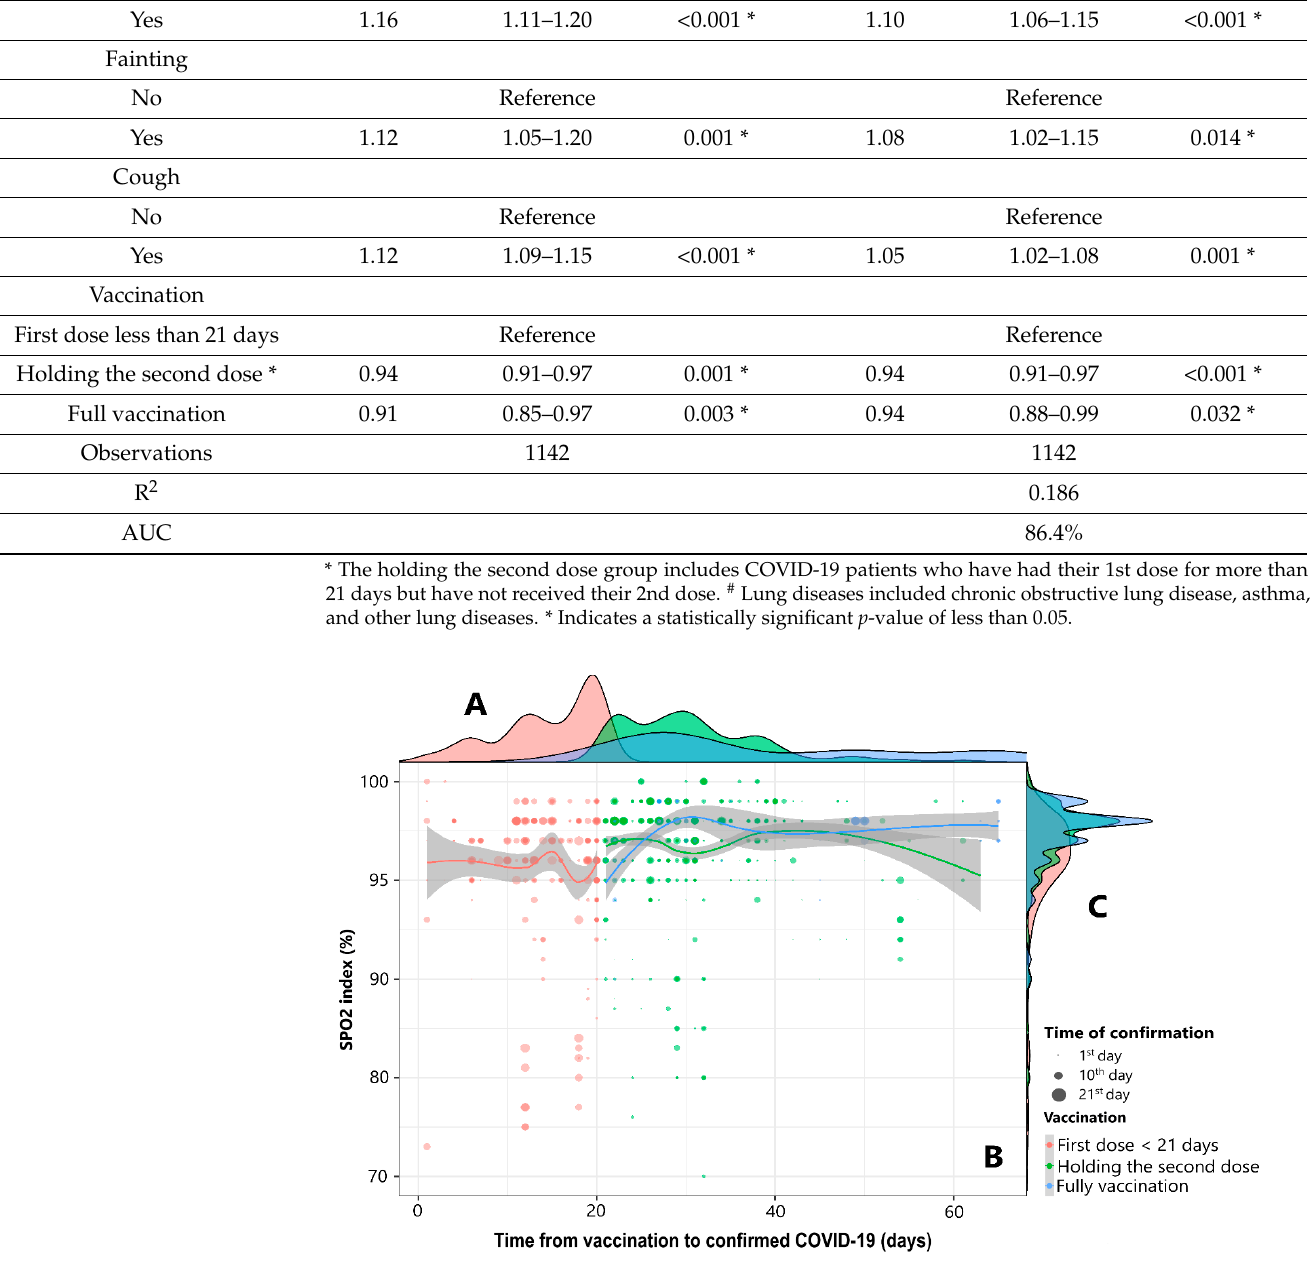
Figure 2. The relationship between the time from vaccination to confirmed COVID-19 and the SPO 2 index by the time of confirmation and vaccination status. Three colors have been used to represent the characteristics of COVID-19 patients, as follows: red represents patients with “first dose < 21 days”, green for “holding the second doses”, and blue for “fully vaccinated”. ( A , C ) use density histograms to show the distribution of the study subjects from the time of illness to the time of the survey and the SPO 2 index. ( B ) uses a scatterplot to show the relationship between the duration of illness and the SPO 2 index, and the size of the circle corresponds to the time between the last vaccination and the survey. Loess regression was used to draw smoothing lines according to the SPO 2 index of patients. The time of vaccination refers to the time from the last dose of the vaccine to the time of study